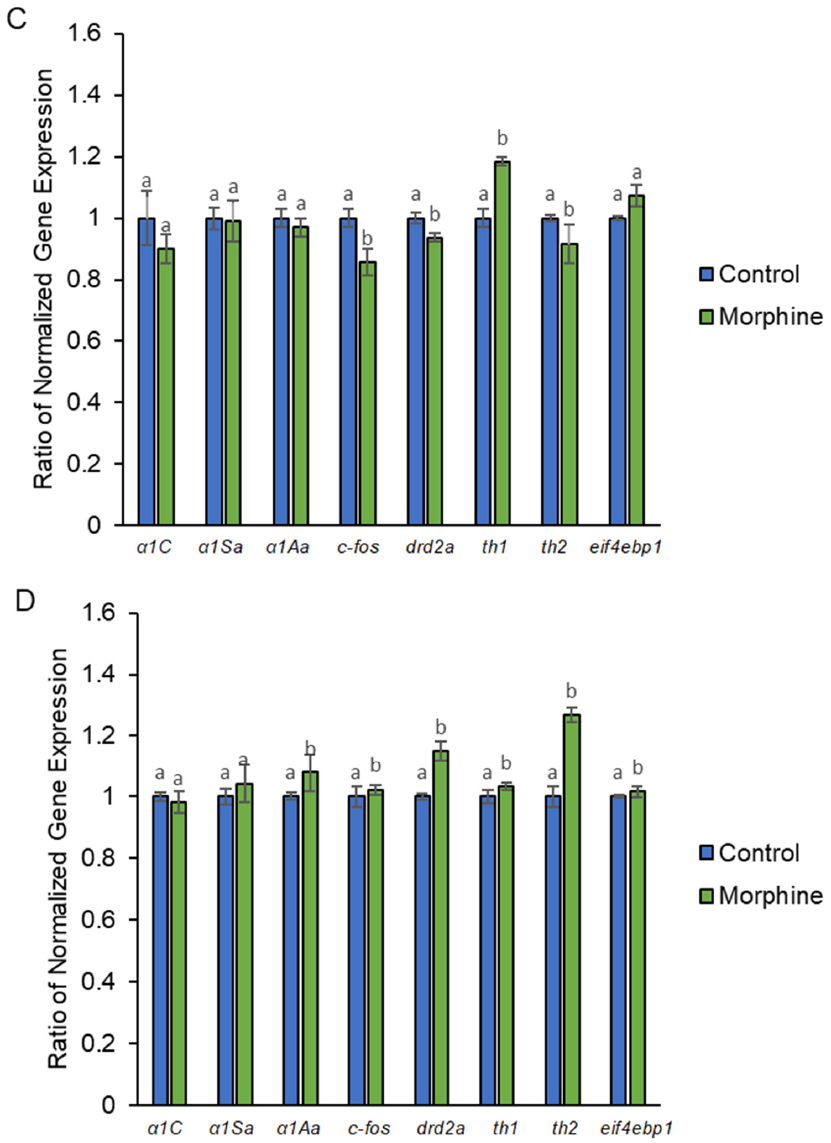
Figure 8. Altered gene expression in zebrafish larvae following exposure to MK801, DMP, and morphine. ( A ) Short-term effect on expression of α 1C (F (3, 32) = 1.62, p = 0.91), α 1Sa (F (3, 32) = 1.57, p = 0.22), α 1Aa (F (3,32) = 1.99, p = 0.13), c-fos (F (3, 32) = 1.50, p = 0.67), drd2a (F (3, 32) = 53.34, p = 0.00), th1 (F (3, 32) = 6.18, p = 0.02), th2 (F (3, 32) = 283.76, p = 0.00), and eif4ebp1 (F (3, 32) = 25.18, p = 0.00). ( B ) Long-term effect on expression of α 1C (F (3,32) = 7.06, p = 0.00), α 1Sa (F (3, 32) = 15.60, p = 0.00), α 1Aa (F (3, 32) = 25.45, p = 0.00), c-fos (F (3,32) = 10.22, p = 0.01), drd2a (F (3, 32) = 264.97, p = 0.00), th1 (F (3, 32) = 292.13, p = 0.00), th2 (F (3, 32) = 617.59, p = 0.00), and eif4ebp1 (F (3,32) = 20.76, p = 0.00). ( C ) Effect of morphine withdrawal of short-term morphine treatment on α 1C (t (16) = 0.19, p = 0.66), α 1Sa (t (16) = 1.13, p = 0.06), α 1Aa (t (16) = 3.84, p = 0.10), c-fos (t (16) = 6.54, p = 0.02), drd2a (t (16) = 42.67, p = 0.00), th1 (t (16) = 54.81, p = 0.00), th2 (t (16) = 0.81, p = 0.38), and eif4ebp1 (t (16) = 11.33, p = 0.00). ( D ) Effect of morphine withdrawal after long-term morphine treatment on α 1C (t (16) = 0.69, p = 0.42), α 1Sa (t (16) = 2.97, p = 0.10), α 1Aa (t (16) = 24.37, p = 0.00), c-fos (t (16) = 7.49, p = 0.01), drd2a (t (16) = 18.02, p = 0.00), th1 (t (16) = 18.11, p = 0.01), th2 (t (16) = 28.78, p = 0.00), and eif4ebp1 (t (16) = 8.10, p = 0.01). Data expressed as mean ± SEM, n = 50 of 3 independent experiments. Different alphabets indicate statistically significant values, p < 0.05. Drug abbreviation: DMP, domperidone.